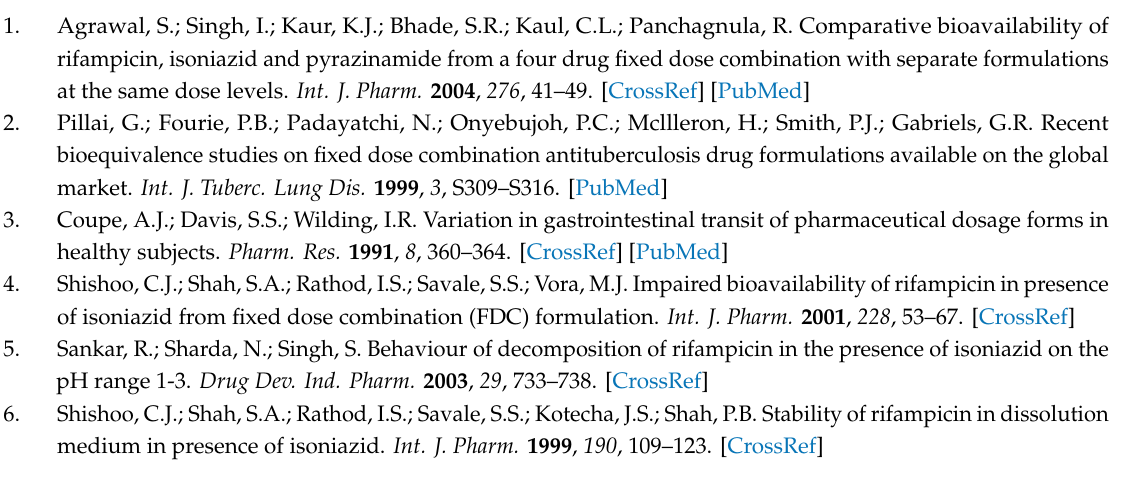
Figure S1: Typical DSC thermogram for isonicotinylhydrazide (INH) generated at a heating rate of 10 ◦ C / min over the temperature range 30–400 ◦ C. Figure S2: Typical DSC thermogram for a 1:1 mixture of INH and hydroxypropyl methylcellulose acetate succinate (HPMC-AS) generated at a heating rate of 10 ◦ C / min over the temperature range 30–400 ◦ C. Figure S3: Typical DSC thermogram for a 1:1 mixture of INH and Eudragit ® L100 generated at a heating rate of 10 ◦ C / min. over the temperature range 30–400 ◦ C. Figure S4: FT Raman spectral data for INH alone and in microspheres. Figure S5: Typical DSC thermogram for rifampicin (RIF) generated at a heating rate of 10 ◦ C / min over the temperature range 30–400 ◦ C. Figure S6: Typical DSC thermogram for a 1:1 mixture of RIF and d-glucose generated at a heating rate of 10 ◦ C / min over the temperature range 30–400 ◦ C. Figure S7: Typical DSC thermogram for a 1:1 mixture of RIF and EC generated at a heating rate of 10 ◦ C / min over the temperature range 30–400 ◦ C. Figure S8: Typical DSC thermogram for a 1:1 mixture of RIF and Eudragit ® RLPO generated at a heating rate of 10 ◦ C / min over the temperature range 30–400 ◦ C. Figure S9: Typical DSC thermogram for a 1:1 mixture of RIF and sodium bicarbonate generated at a heating rate of 10 ◦ C / min over the temperature range 30–400 ◦ C. Figure S10: Typical DSC thermogram for a 1:1 mixture of RIF and sodium bicarbonate generated at a heating rate of 10 ◦ C / min over the temperature range 30–400 ◦ C. Figure S11: FTIR absorption spectrum of RIF (black) and a 1:1 mixture of RIF and EC (red). Figure S12: FTIR absorption spectrum of RIF (black) and a 1:1 mixture of RIF and d-glucose (red). Figure S13: FTIR absorption spectrum of RIF (black) and a 1:1 mixture of RIF and Eudragit ® RLPO (red). Figure S14: FTIR absorption spectrum of RIF (black) and a 1:1 mixture of RIF and sodium bicarbonate (red). Figure S15: FTIR absorption spectrum of RIF (black) and a 1:1 mixture of RIF and citric acid (red). Table S1: FT Raman shifts and assignments for isonicotinylhydrazide (INH) powder and microspheres. Table S2: FTIR wavenumber number assignments for RIF and 1:1 mixtures. Table S3: Actual experiments conducted and responses observed for RIF using a Box Behknen Design